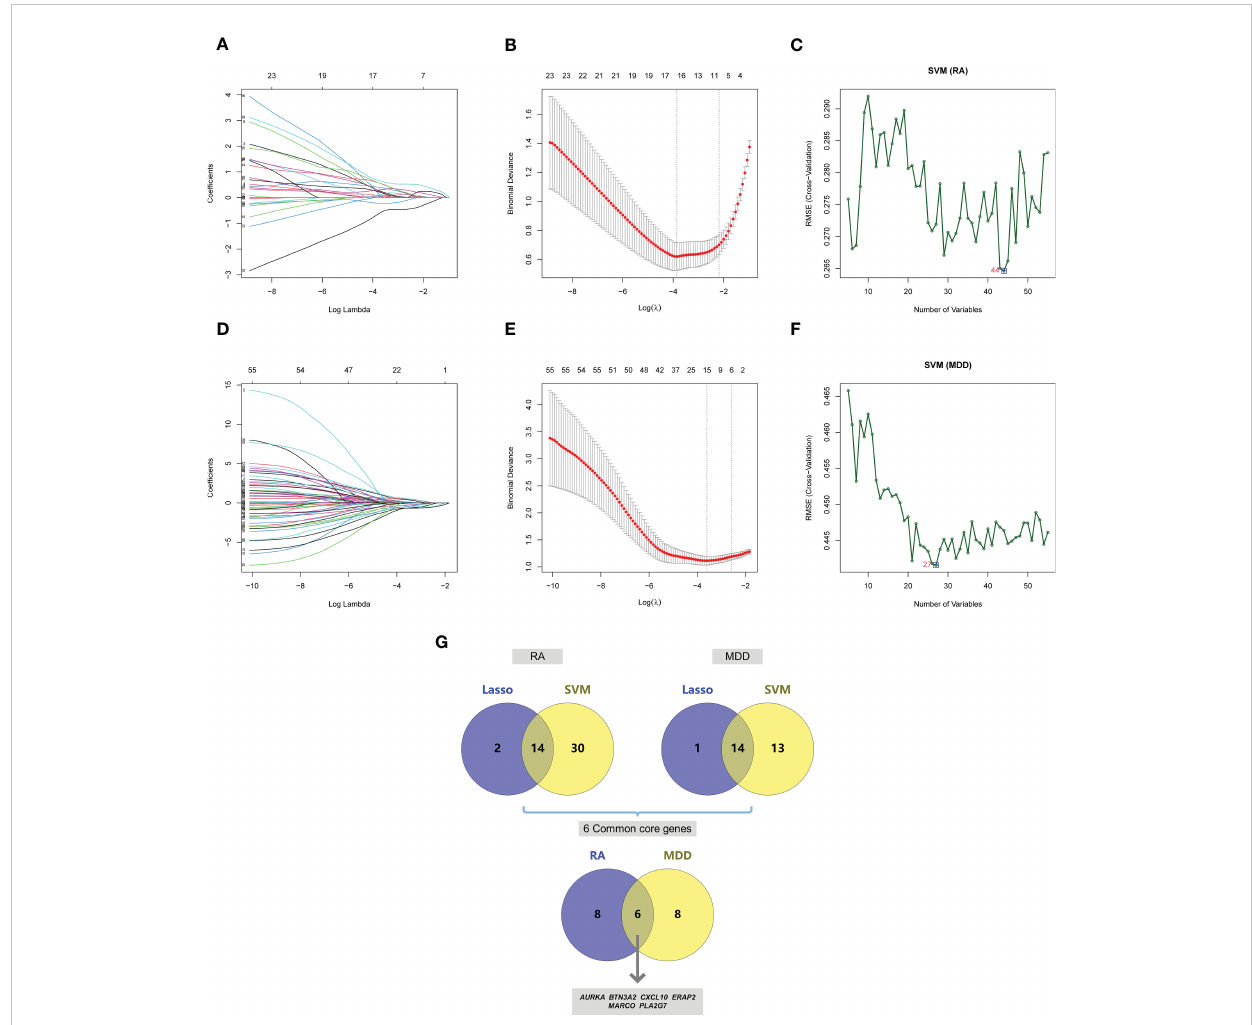
FIGURE 6 Screening of core genes and validation based on machine learning methods in RA and MDD. (A) Coef fi cient pro fi les of variables in the LASSO regression model in RA. (B) Ten-fold cross-validation for turning parameter ( l ) selection in the LASSO regression model in RA. (C) The optimum root mean squared error (RMSE) of SVM-based method based on 44 characteristic genes in RA. (D) Coef fi cient pro fi les of variables in the LASSO regression model in MDD. (E) Ten-fold cross-validation for turning parameter ( l ) selection in the LASSO regression model in MDD. (F) The optimum root mean squared error (RMSE) of SVM-based method based on 27 characteristic genes in MDD. (G) 14 core genes in RA and 14 core genes in MDD screened by LASSO regression model and SVM-based method, and 6 common core genes were obtained after taking the